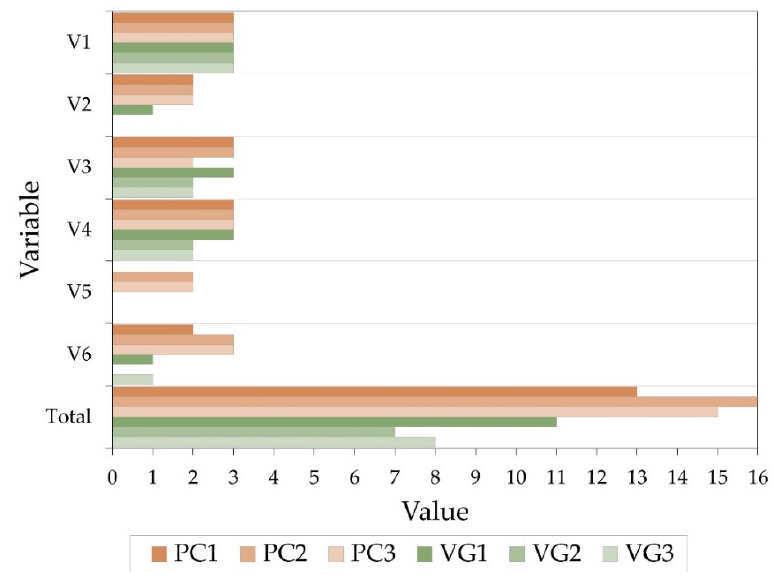
Figure 5. Performance of each section.